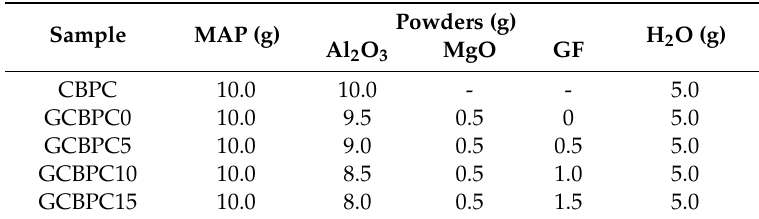
Table 2. Mixture proportion of phosphate ceramic coating pastes.